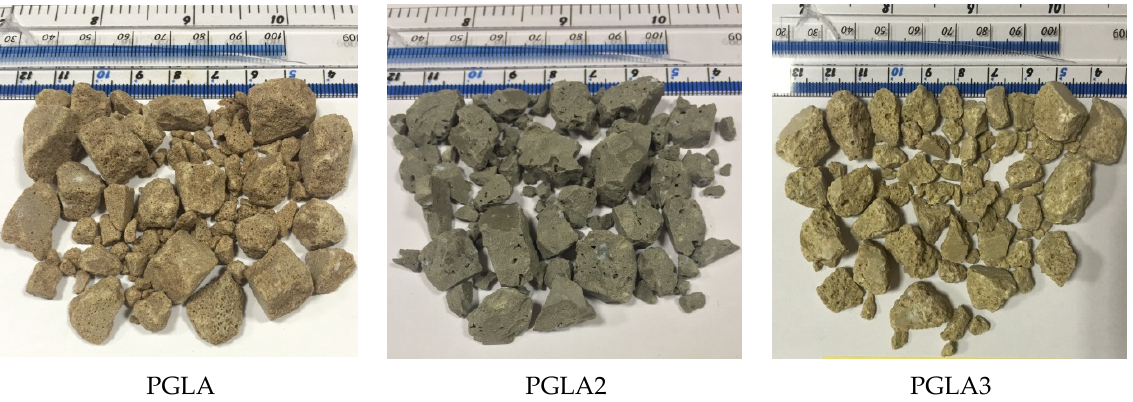
Figure 6. Different types of PGLAs developed using plastic waste and mineral additives.